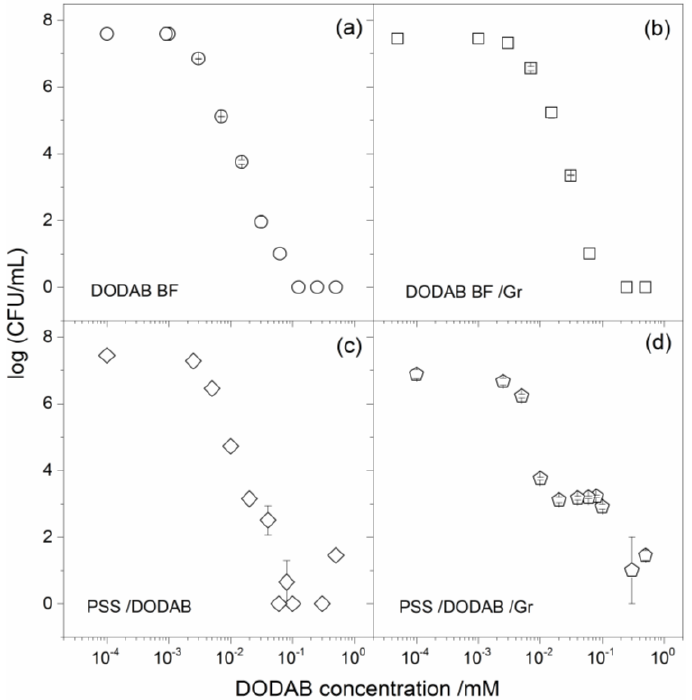
Figure 4. The microbicidal activity of biomimetic cationic NPs of PSS/DODAB and PSS/DODAB/Gr against E. coli . Cell viability of E. coli , in log (CFU/mL), as a function of DODAB concentration for different DODAB assemblies: ( a ) DODAB BF; ( b ) DODAB BF/Gr where Gr concentration is 10% of the DODAB concentration; ( c ) PSS/DODAB; ( d ) PSS/DODAB/Gr where Gr concentration is 10% of the DODAB concentration. Initial cell concentration was in the range (1–4) × 10 7 CFU/mL. The ratio between DODAB concentration and NPs concentration was 10 µM DODAB per 2.4 × 10 10 PSS particles/mL. DODAB and Gr concentration varied with the particle number density in (c) and (d). After 1 h interaction between cells and assemblies, dilution and plating of the mixtures allowed CFU counting.